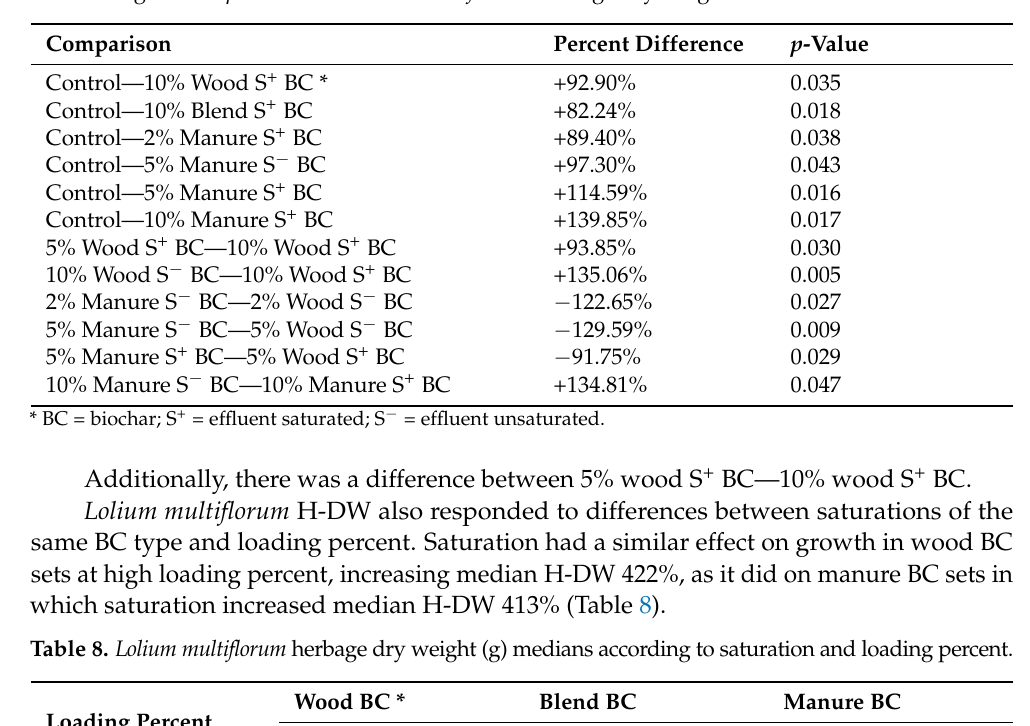
Table 7. Significant p -values for Lolium multiflorum herbage dry weight.